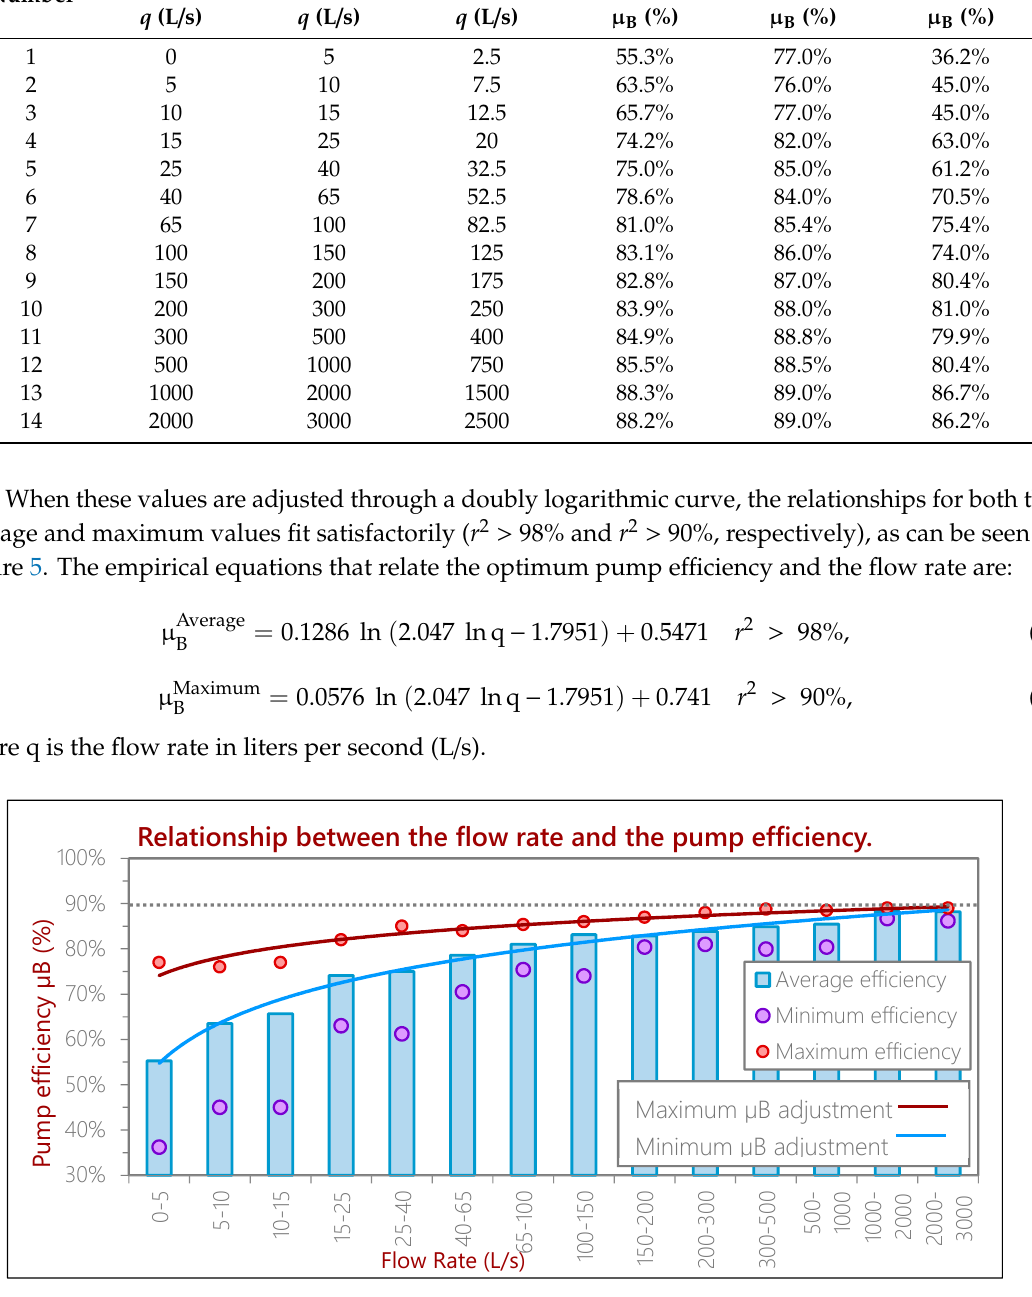
Table 1. Elaboration of the adjusted curves of the pump efficiency versus the flow rate.